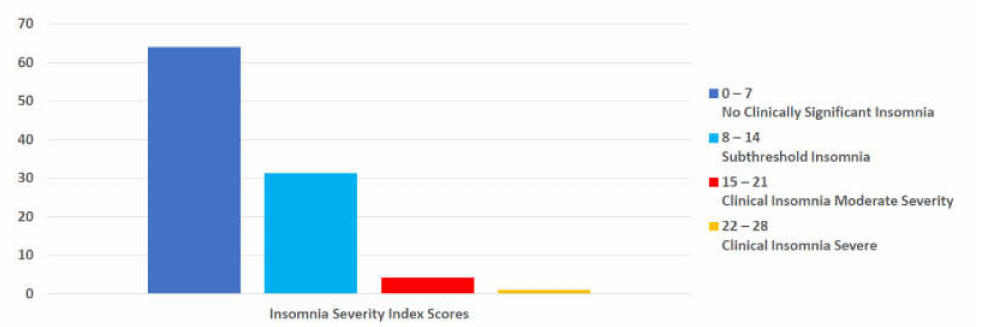
Figure 3. Percent of participants reporting sleep disturbances by Insomnia Severity Index (ISI) category. ( n =